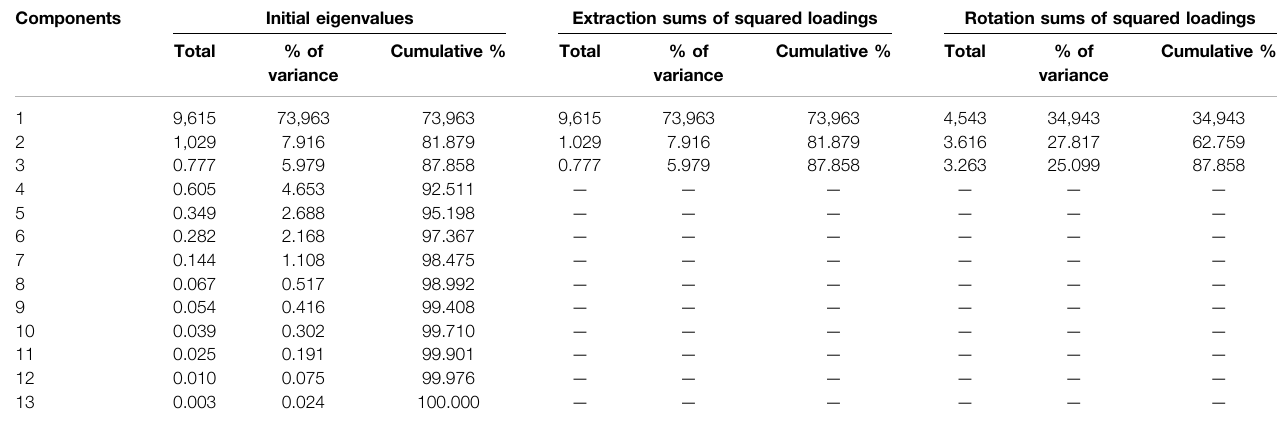
TABLE 7 | Total variance explained.